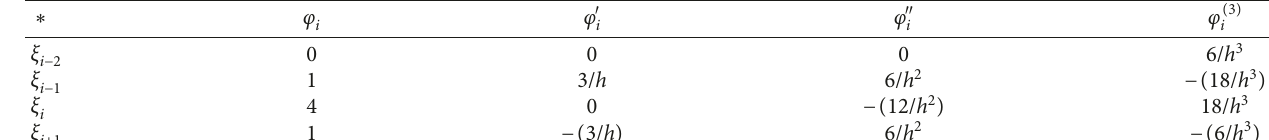
Table 3: Formulas for cubic splines at nodes.